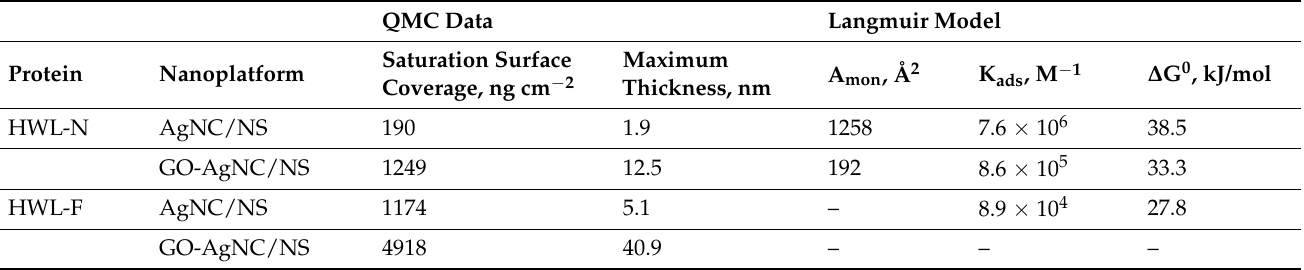
Table 1. Structural characterization of HWL-N and HWL-F adsorption on the nanosensor platforms obtained from the fit of the experimental data to the Langmuir